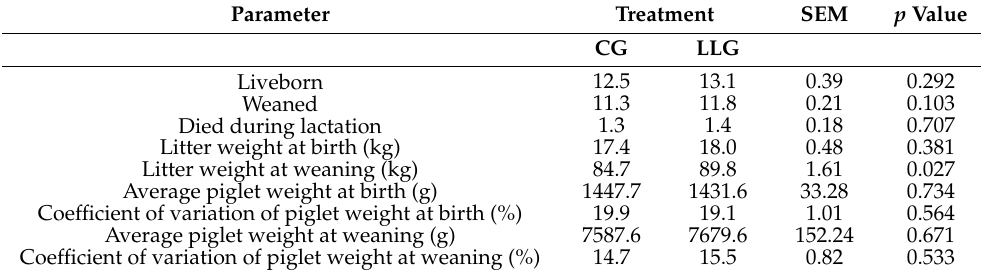
Table 3. Effects of treatments on piglet performance parameters ( n = 30 per